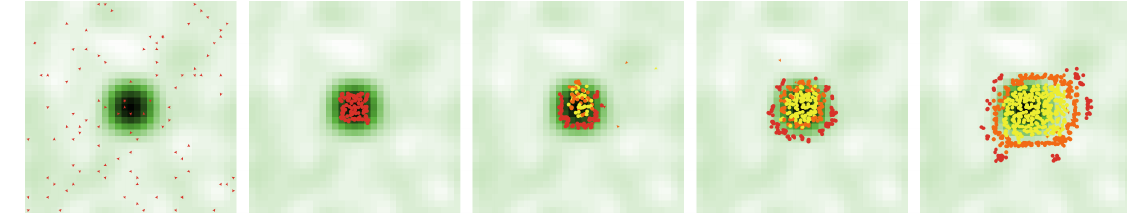
Figure 5. Evolution of Set C over time, from initialization (left) through end of simulation (right).